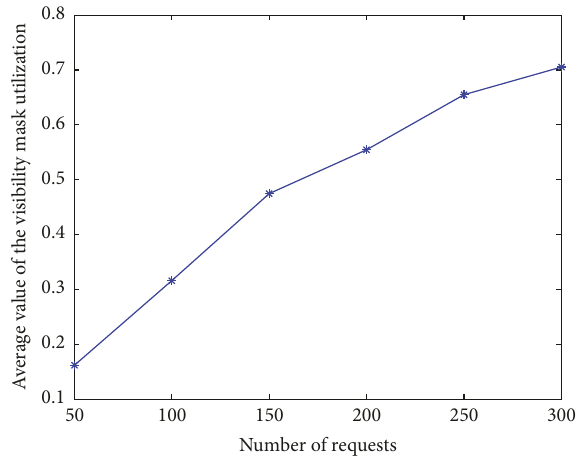
Figure 7: The average values of 𝑉𝑈 in HGA for different groups of